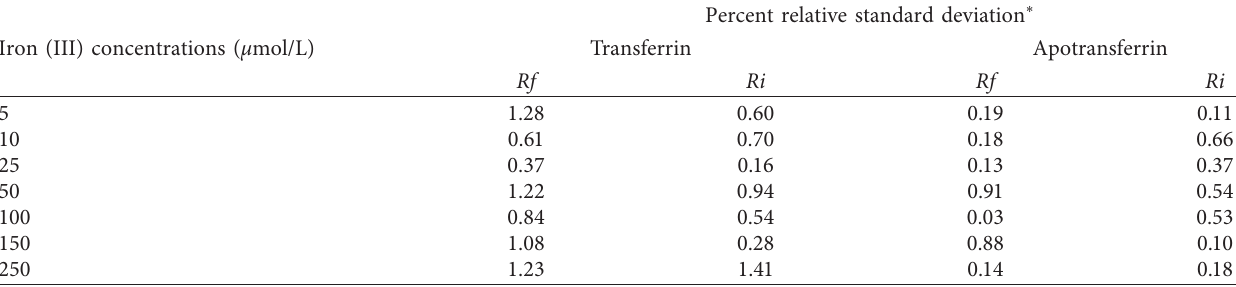
Table 1: Percent relative standard deviation (% RSD) of mobility ratios recorded from transferrin- and apotransferrin-iron (III) interactions at different iron (III) ion concentrations. Iron (III) concentrations ( μ